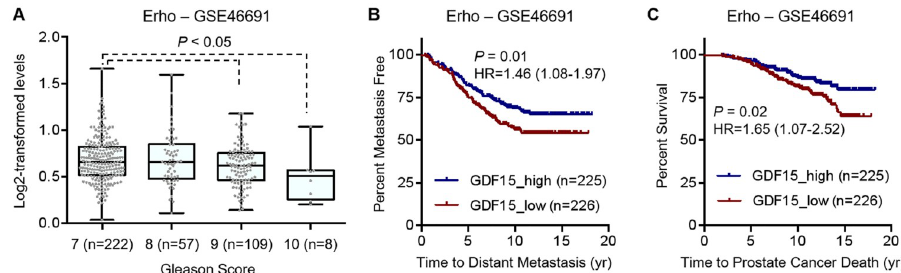
Fig 4. Low GDF15 levels are associated with high Gleason scores in primary tumors and shorter survival of the patients. Data are from the Erho GenomeDx Biosciences cohort. A , association of low GDF15 expression with high Gleason scores. P values are from Mann-Whitney test. B & C , Kaplan-Meier plots showing association of low GDF15 expression with shorter time to distant metastasis (B) and to prostate cancer-specific death (C) after radical prostatectomy. P values and hazard ratios (HR) are from Log-rank test. Numbers in parentheses, number of samples in each group.